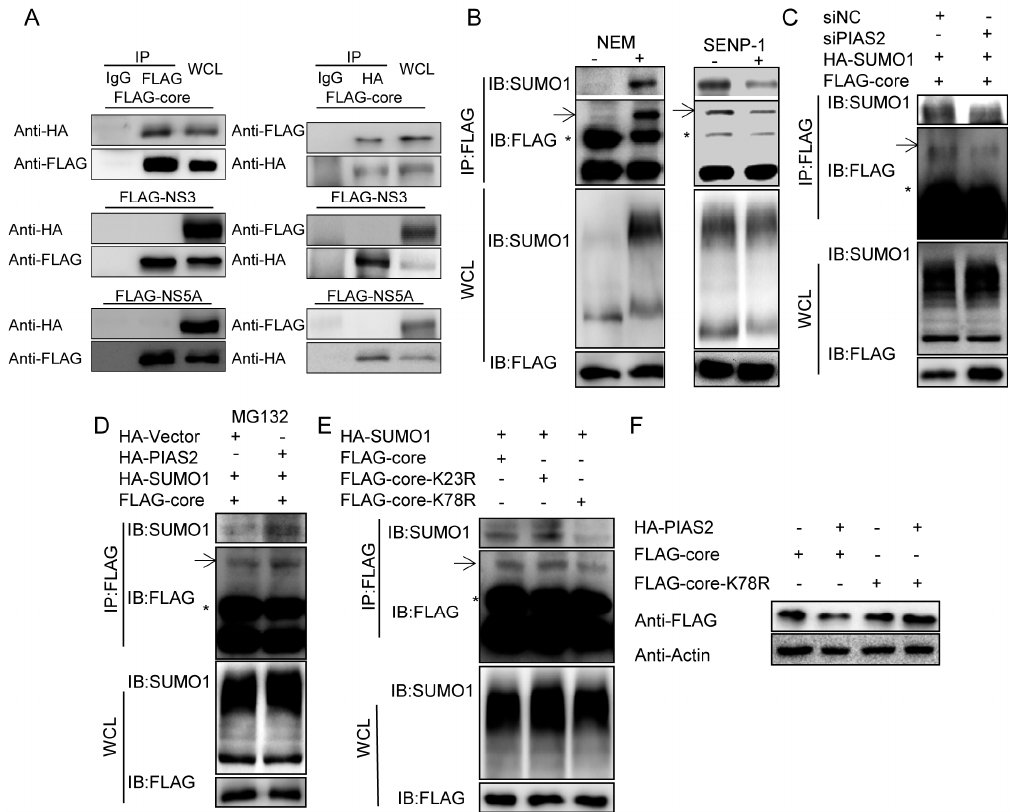
Figure 7. PIAS2 interacts with and enhances SUMOylation of the core protein. ( A ) 293T cells were transfected with pHA-PIAS2, HCV protein expression plasmids and pCer-SUMO1. Left panel, immunoprecipitation was performed with a FLAG or IgG antibody. Right panel, immunoprecipitation was performed with an HA or IgG antibody; ( B ) left panel, 293T cells were transfected with pHA-SUMO1 and pFLAG-core for 48 h. Total protein was collected with or without N -ethylmaleimide (NEM) in the lysis buffer, and immunoprecipitation was performed with a FLAG antibody. Right panel, 293T cells were transfected with pHA-SUMO1, pFLAG-core and p SUMO-sentrin specific protease (SENP-1) or pVector. Total proteins were collected using lysis buffer with NEM, and immunoprecipitation was performed with a FLAG antibody. The arrow shows the SUMOylated core protein band, and the asterisk indicates the location of the light chain; ( C – E ) 293T cells were transfected with siRNA and/or plasmids as indicated. Total protein was collected using lysis buffer with NEM. Immunoprecipitation followed by western blotting was performed with the indicated antibodies; ( F ) 293T cells were transfected with the plasmids as indicated, and the expression levels of the core protein were detected by Western